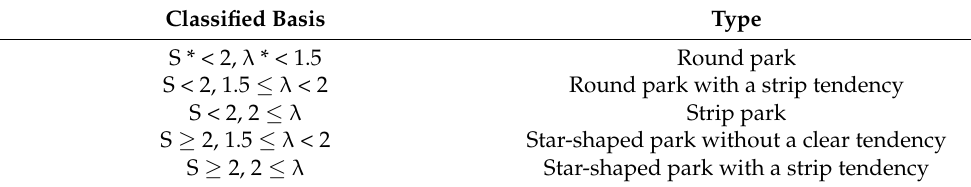
Table 2. Quantitative classification results of the spatial morphology of 117 urban